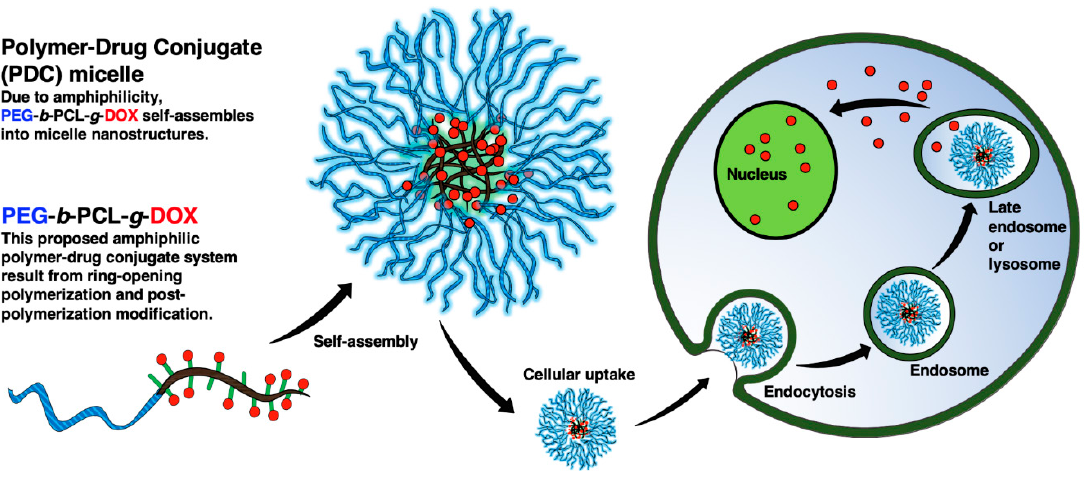
Figure 1. Conceptual schematic of anticancer drug delivery using PEG- b -PCL- g -DOX PDC